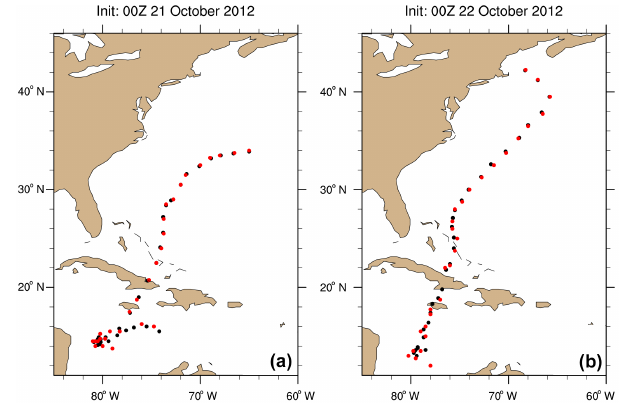
Figure 7. Tropical easterly wave counts within each 2 ◦ cell, over the period 1979–2010, obtained using the procedure de- scribed in Sect. 3.3.